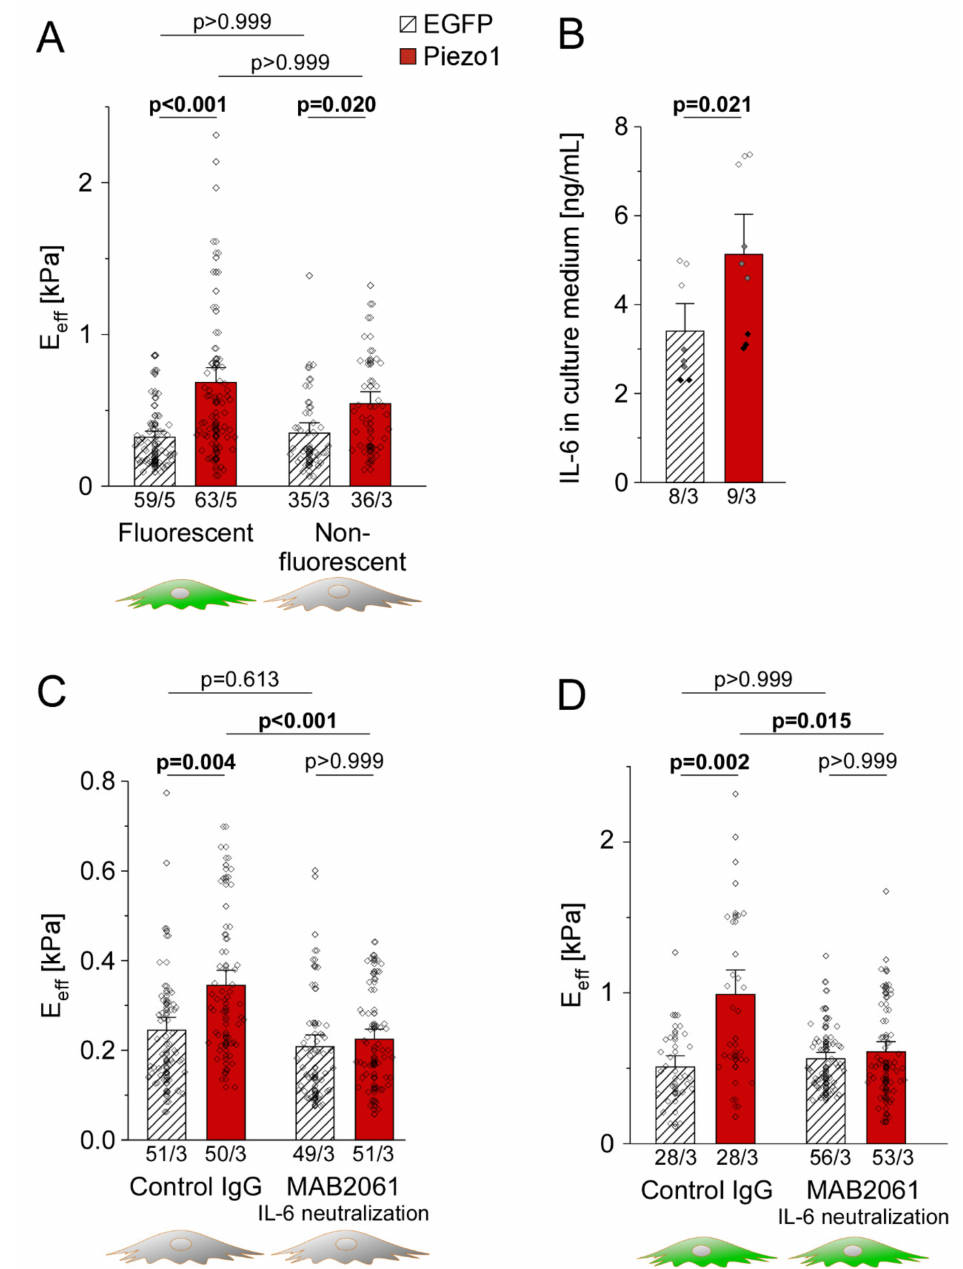
Figure 7. Piezo1-induced stiffening is transmitted to non-transfected cells by a paracrine mechanism dependent on IL-6. ( A ) average stiffness of HAF successfully transfected (fluorescent) or non- transfected (non-fluorescent) in the same dish. ( B ) IL-6 concentration in the culture medium analyzed 3 days after transfection of EGFP or Piezo1. Average stiffness of non-transfected ( C ) and transfected cells ( D ) after treatment with a non-targeting control IgG or IL-6 neutralizing antibody MAB2061 (0.6 µ g/mL) for 2 days. n/N = number of cells/ number of experiments (except for B, where n = number of